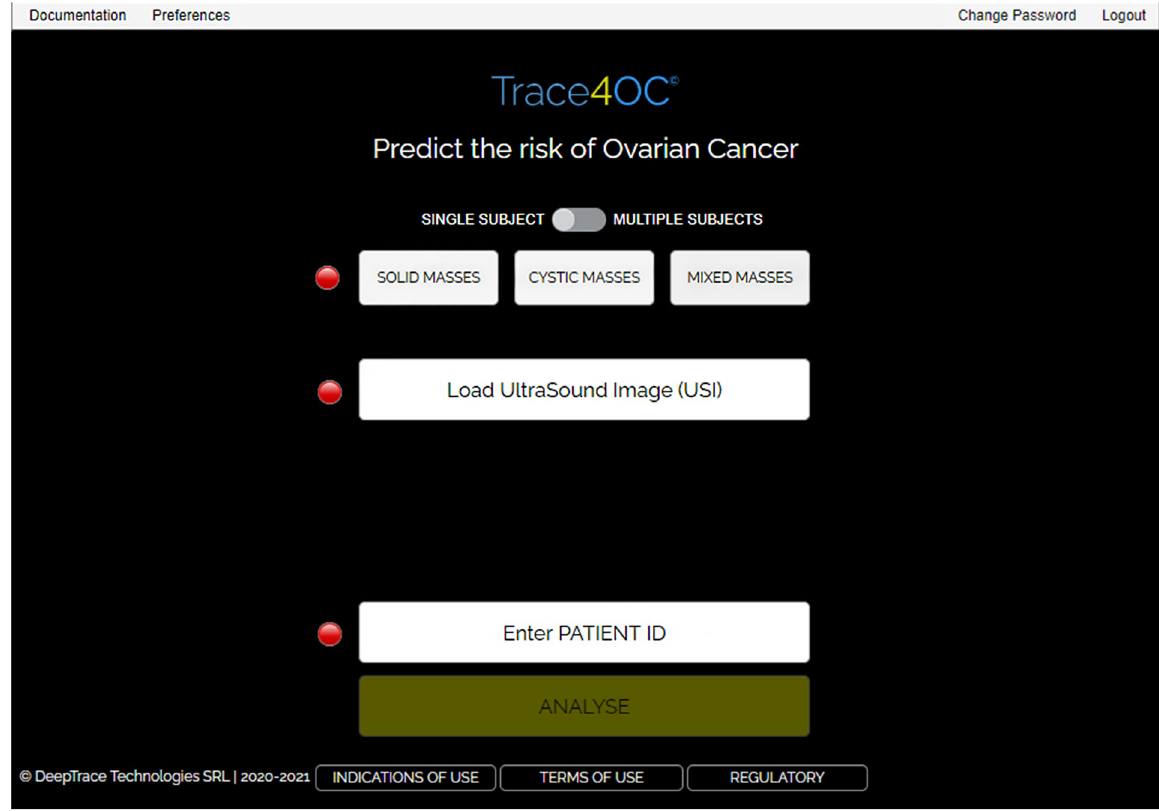
Fig. 1 Software interface for the mass types and transvaginal ultrasound image